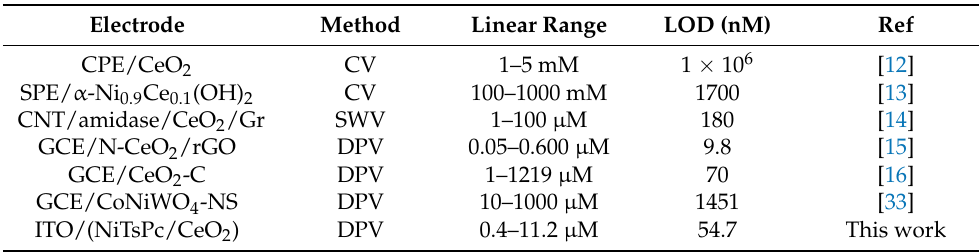
Table 1. Configuration and performance of different electroanalytical methods for determination of acetaminophen.